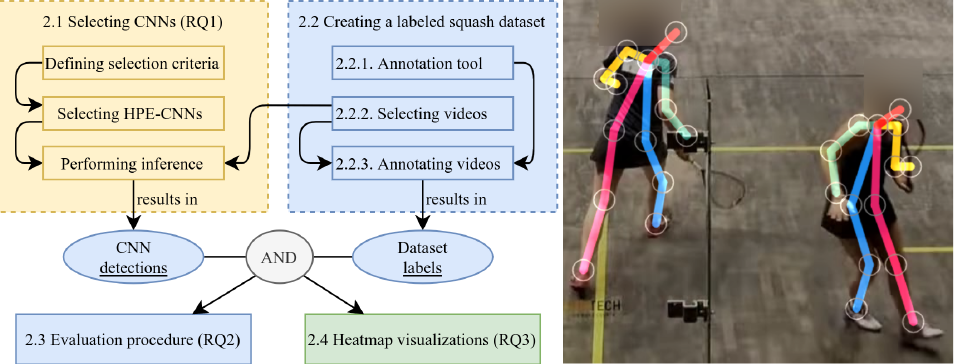
Figure 1. Illustration and example of the different components and their relationship. Left: Section 2.1: Selecting different pre-trained human pose estimation convolutional neural networks (HPE-CNNs) and performing inference, results in CNN detections. Section 2.2: Manually creating a labeled squash dataset by annotating selected videos, results in (ground truth) dataset labels. Section 2.3: Evaluating detections regarding labels using our evaluation procedure. Section 2.4: Utilizing detections and labels for heatmap visualizations. Right: Example detections (circles) of a CNN-based connected human body pose estimator overlaid on the processed video